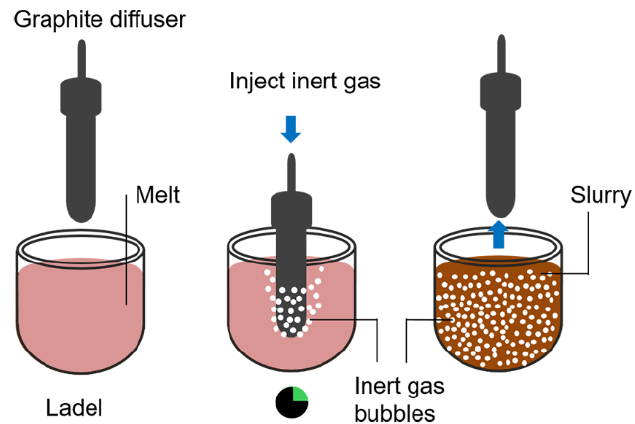
Figure 11. Schematic diagram of the steps of the GISS method [130,132]. Reprinted with permission from Ref. [130]. Copyright 2010 Elsevier.